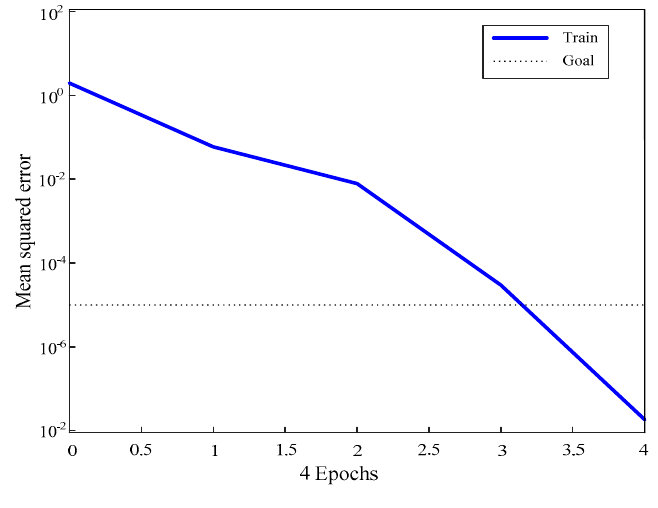
Figure 6. Training error reduction process.